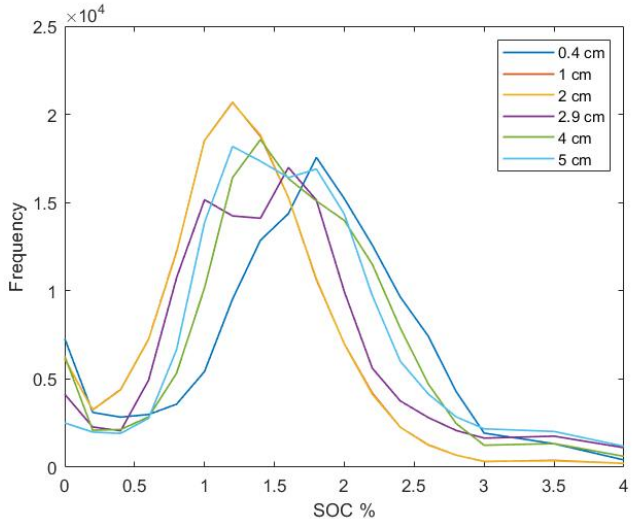
Figure 11. Histogram of the estimated SOC content from both the sites with varying WV. There is variation in the SOC map using WV of 0.4, 4, and 5 cm, respectively (Figure 11), compared to the rest of the maps, which are fairly consistent. Variation in the pixels around and between vegetation can also be observed. This can be clearly seen in the standard deviation map (Figure 13). High standard deviation is observed along the riverbed due to no bare soil pixel and the mixture of water and vegetation pixels in site#2. A couple of prominent stripes in site#1 and site#2 are observed. In site#1, high standard deviations are observed along the farm